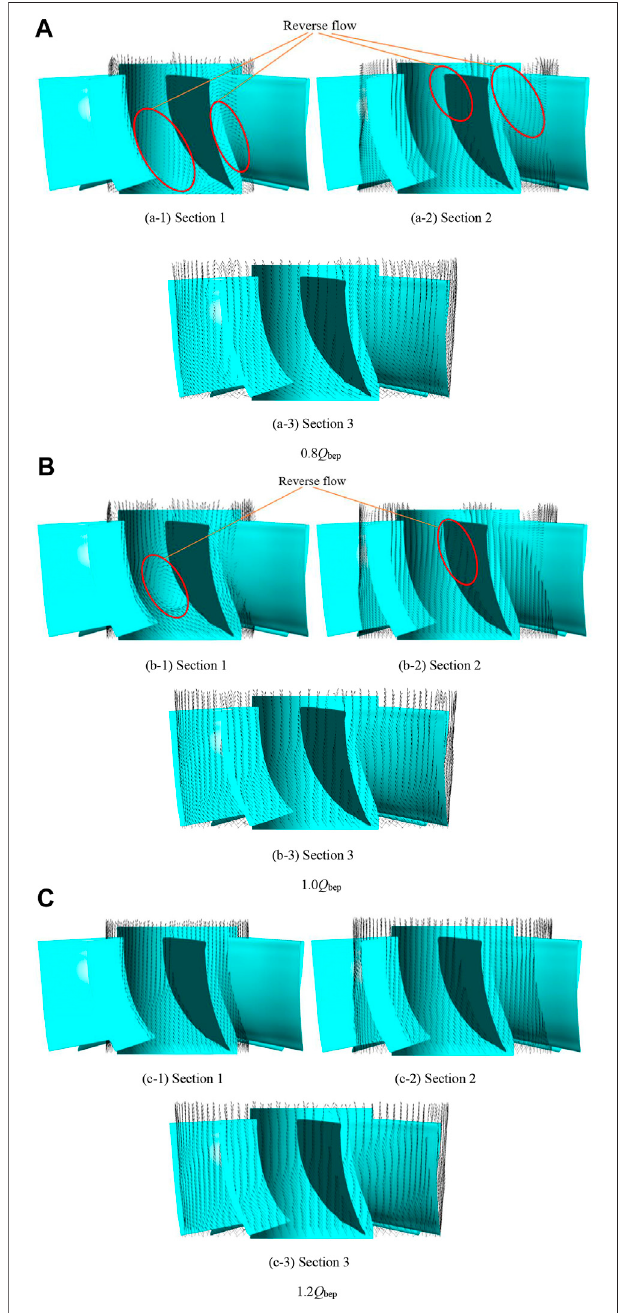
FIGURE 15 | Flow fi eld diagram of guide vane with different